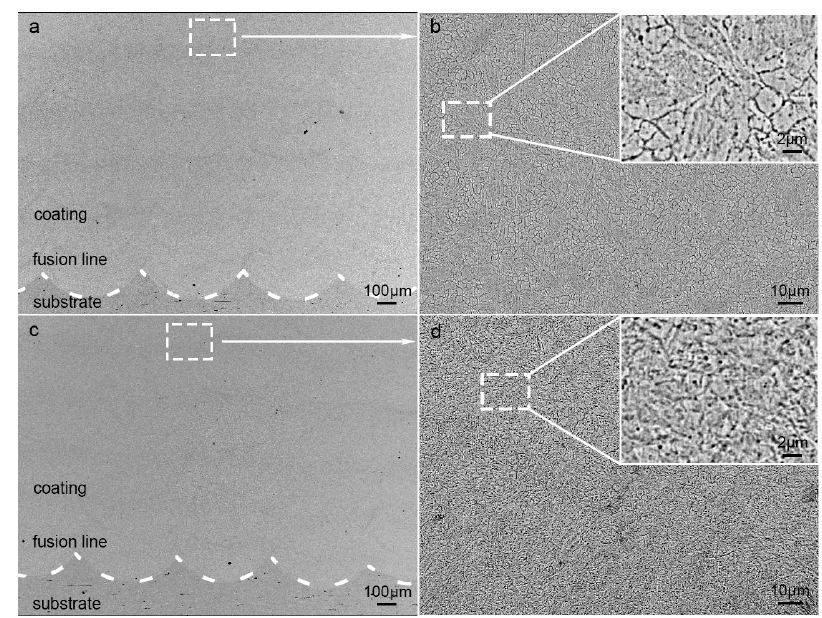
Figure 3. The cross-section SEM micrographs of the specimens: ( a , b ) as-cladded; ( c , d ) as-tempered.